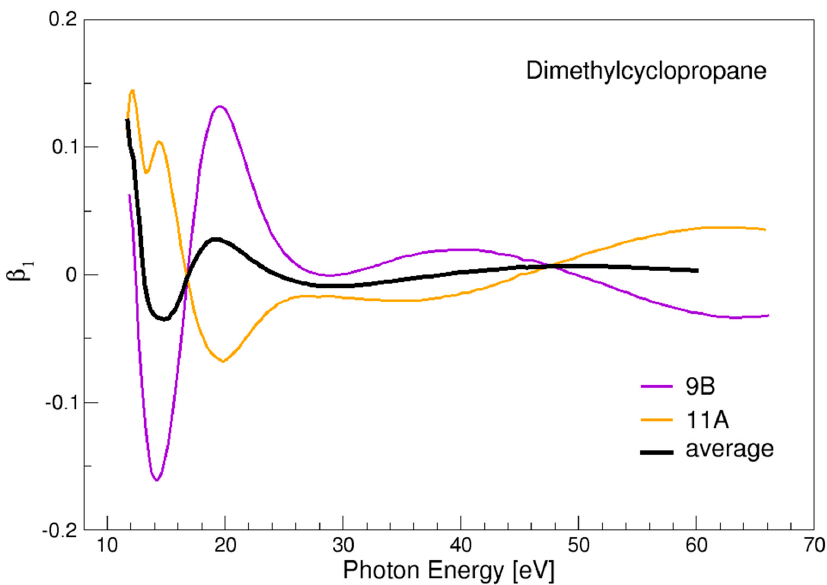
Figure 3. β 1 parameter for the two outermost ionizations, 11A and 9B, and the average value, in dimethylcyclopropane.